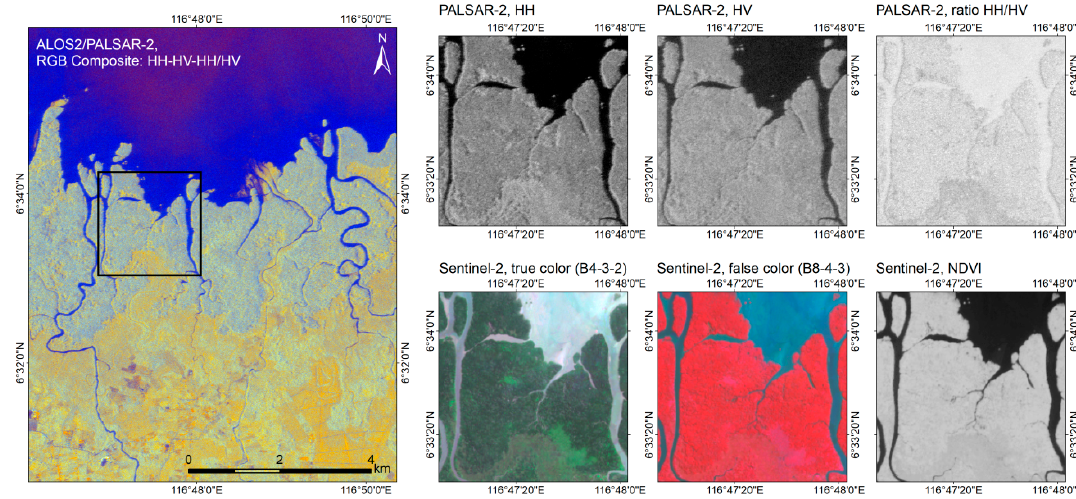
Figure 5. Large image : appearance of mangroves for a coastal site in Borneo, Indonesia in an L-band Synthetic Aperture Radar (SAR) image. Image data: ALOS-2 / PALSAR-2 Fine Beam Double polarization (FBD) mode. Zoom boxes on the right side: Top images : Dual-pol L-band SAR image in HH and HV polarization and its ratio (HH / HV) in comparison with bottom images : optical multispectral satellite data (Sentinel-2) in Visible (VIS) true color, VIS-Near-InfraRed (NIR) false color and Normalized Di ff erence Vegetation Index (NDVI).